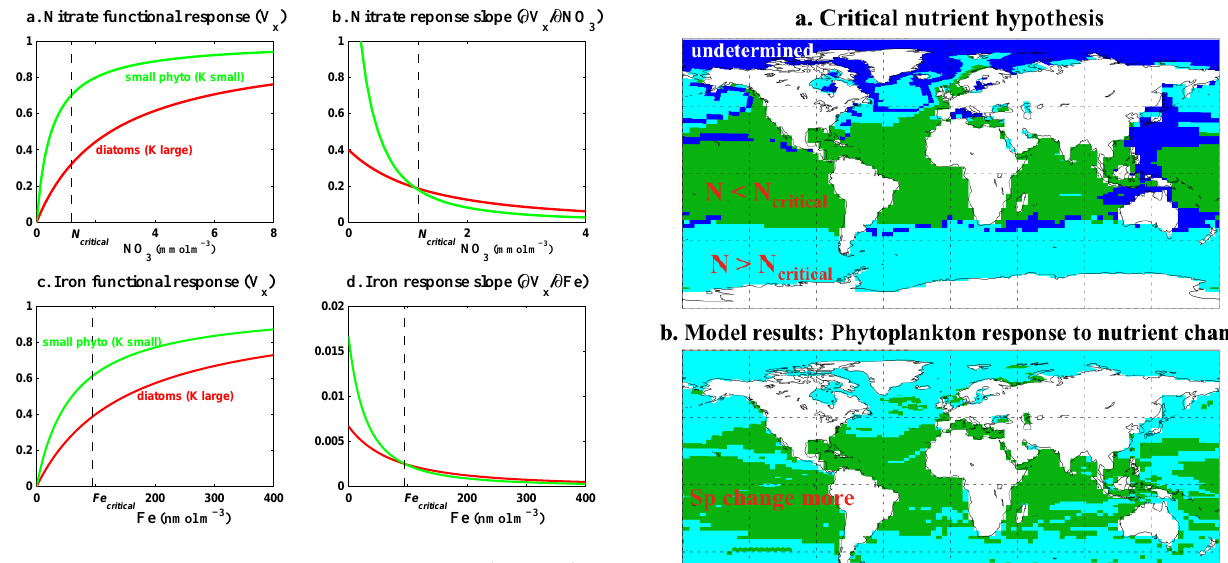
Fig. 9. Illustration of the critical nutrient hypothesis (Sect. 3.2) for nitrate or iron limited regions. For both small phytoplankton (green) and diatoms (red) we show (a) nitrate functional response versus ni- trate concentration, (b) the slope of nitrate functional response, (c) iron functional response versus iron concentration and (d) the slope of iron functional response. Below the critical nutrient concentra- tion, a change in ambient nutrient impacts more small phytoplank- ton than diatoms.